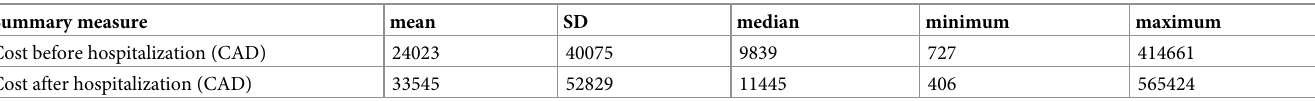
Table 2. Health care costs incurred 12 months before and after hospitalization (n = 1695). Summary